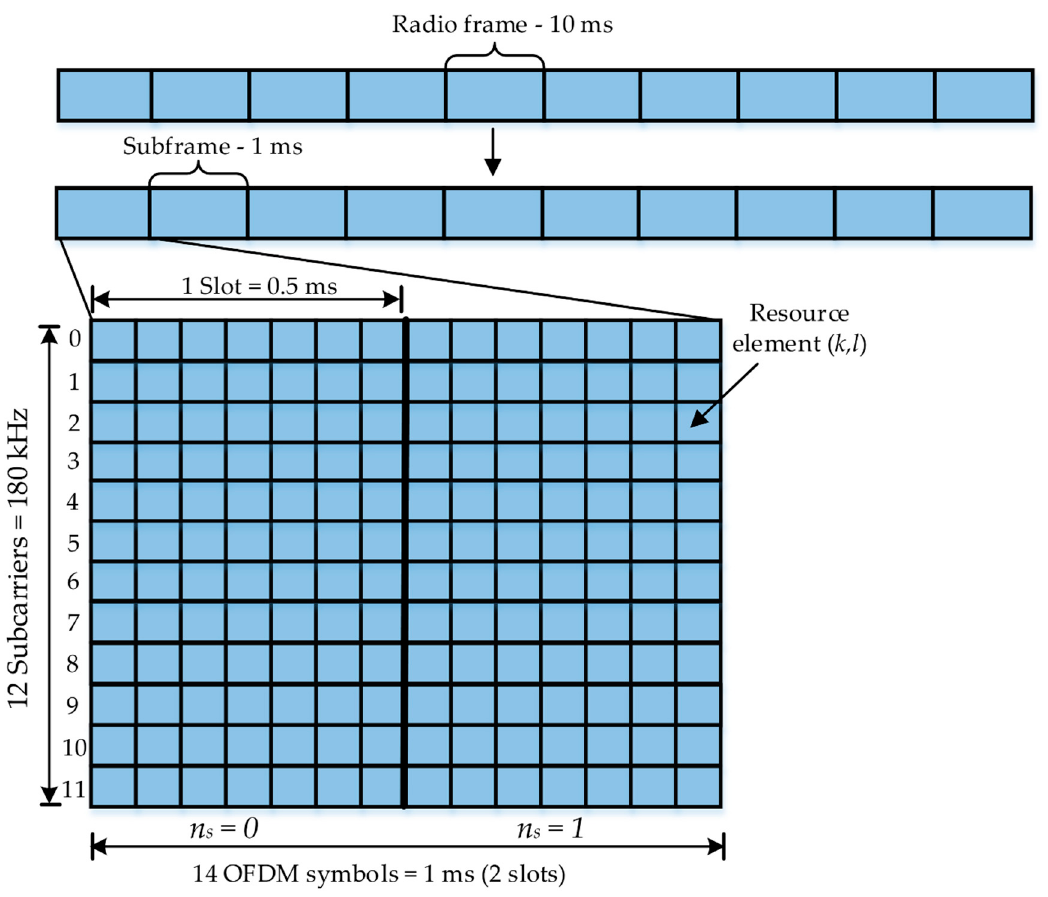
Figure 2. Frequency time grid of NB-IoT downlink systems.